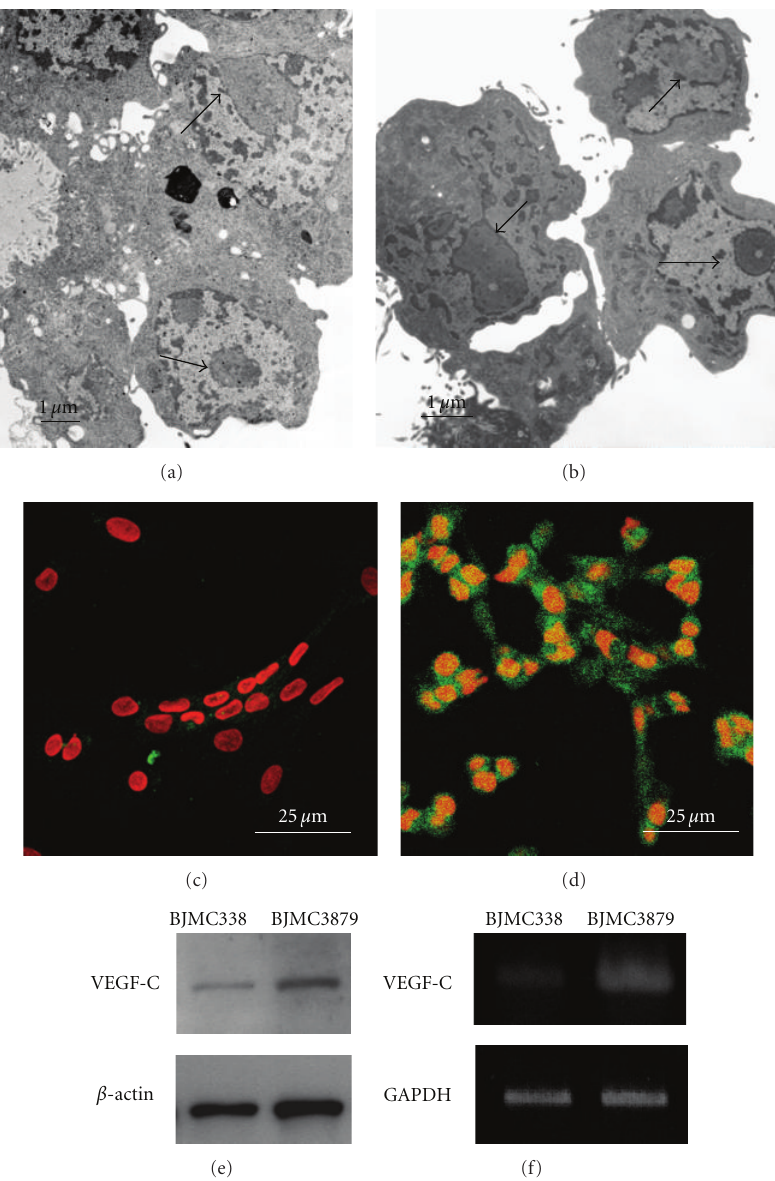
Figure 1: TEM micrographs (a and b), immunofluorecent staining (c and d), Western blot analysis (e), and RT-PCR analysis (f) of VEGF- C in the two-mouse mammary carcinoma cell lines. Both BJMC338 cells (a) and BJMC3879 cells (b) have the similar ultrastructure. BJMC338 cells (c) have minimally any activity of VEGF-C, whereas BJMC3879 cells (d) have moderate expression. Western blot analysis (e) demonstrates the same activity of VEGF-C as in (c and d). VEGF-C mRNA expression in BJMC3879 cells is higher than that of BJMC338 cells (f). Green fluorescence (FITC) indicates activity of VEGF-C, and red fluorescence (PI) shows nuclei of cells in (c and